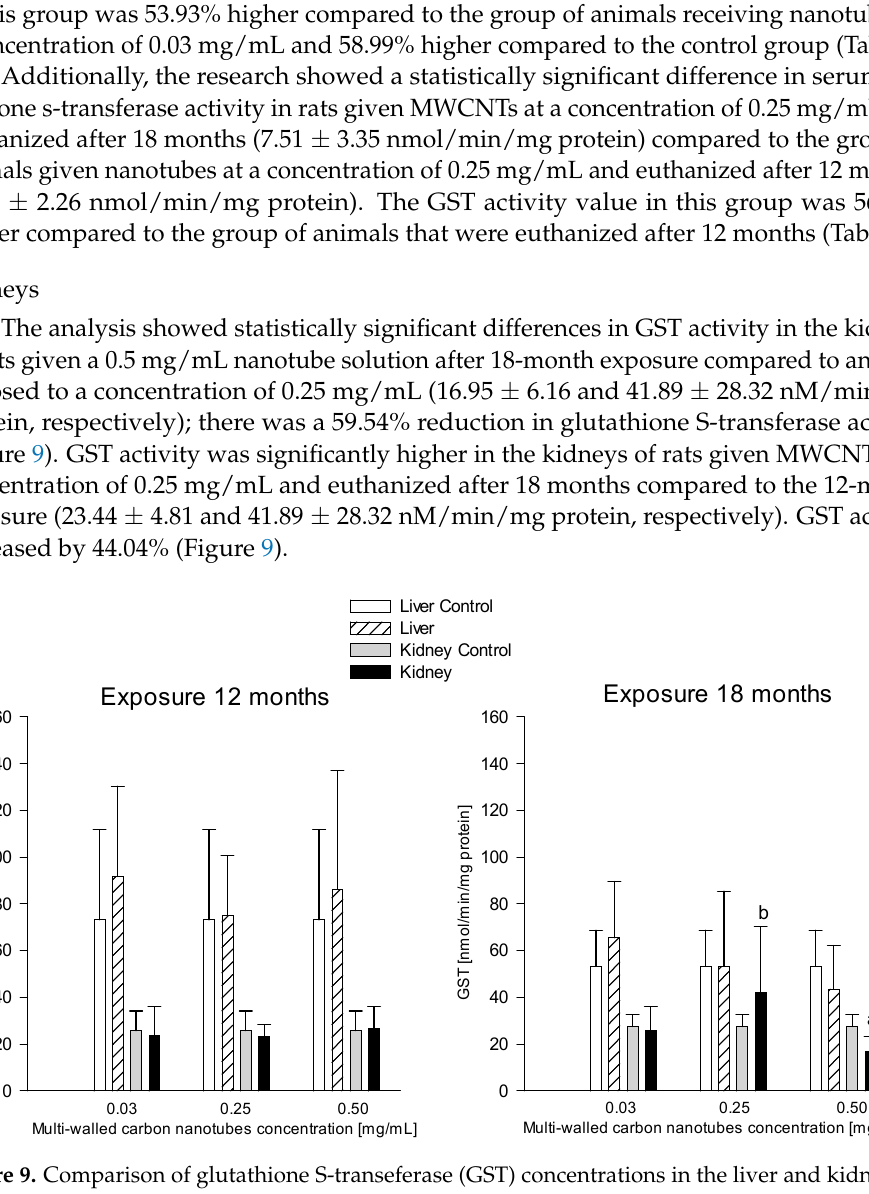
Figure 9. Comparison of glutathione S-transeferase (GST) concentrations in the liver and kidneys of animals exposed to multi-walled carbon nanotubes for 12 and 18 months. (a)—statistically significant difference for MWCNTs in concentration of 0.5 mg/mL versus 0.25 mg/mL in the kidneys ( p = 0.0178), (b)—statistically significant difference for MWCNTs in concentration of 0.25 mg/mL at 18 months versus 12 months in the kidneys (p = 0.041126 ).